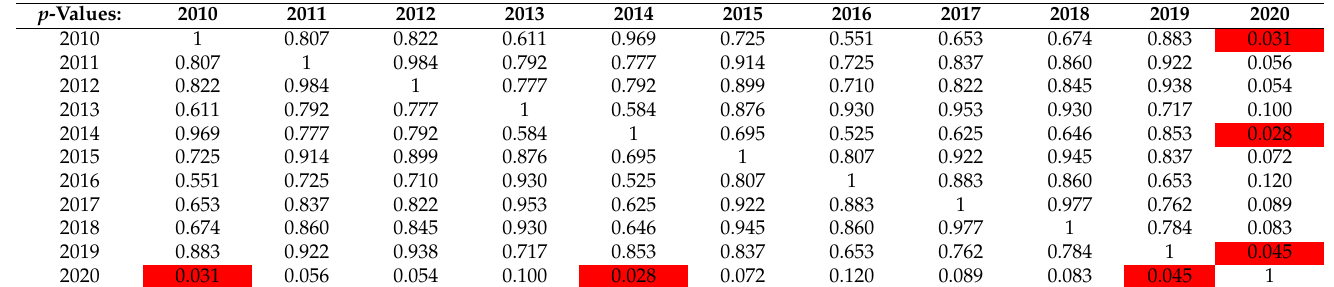
Table 3. Kruskal–Wallis test regarding birds assemblages among years 2010–2020.